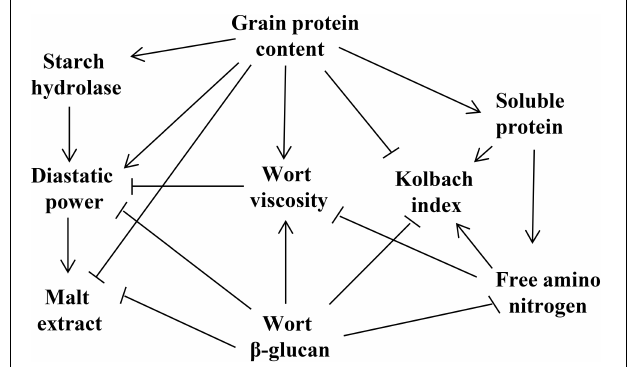
FIGURE 1 | The correlation of malting quality traits. Arrows indicate positive interactions between parameters, and terminally barred lines indicate negative